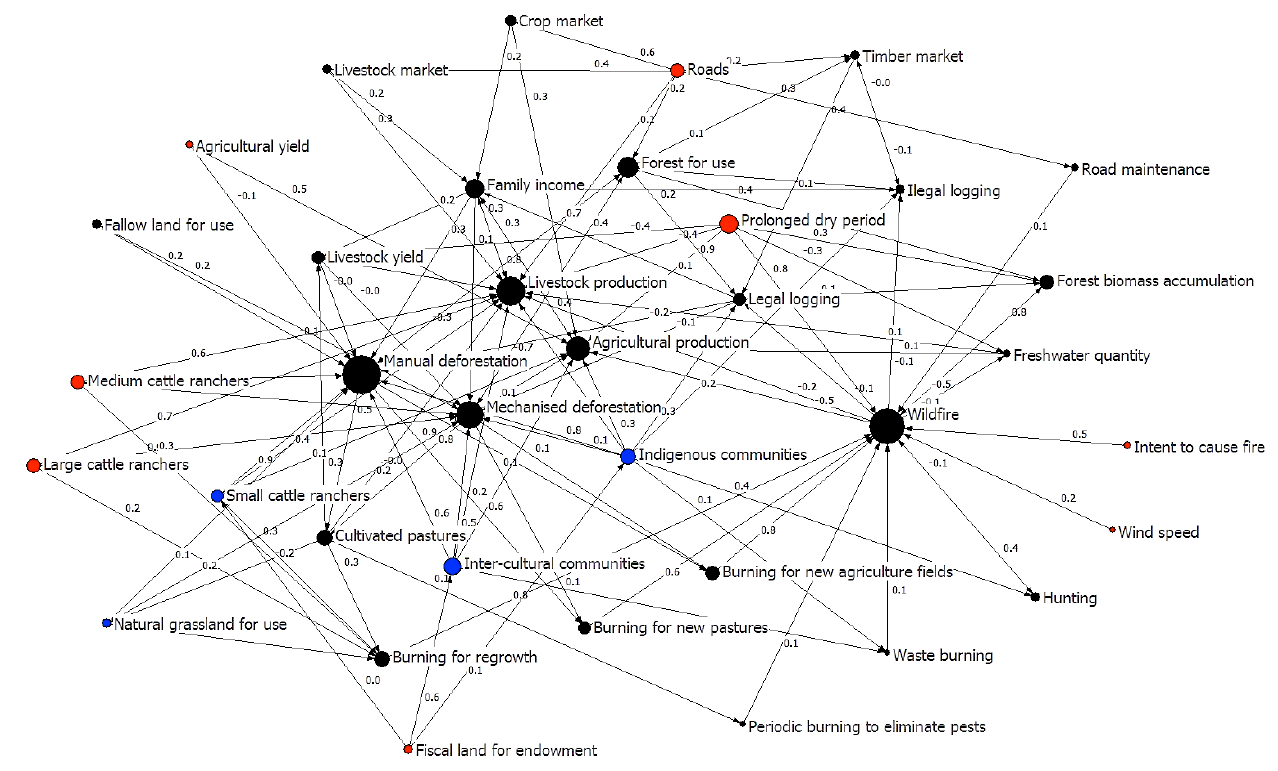
Fig. 3 . Network visualization of the augmented fuzzy cognitive map. Node size represents degree centrality where variables with higher degree have larger nodes. Transmitter variables are presented in red and ordinary transmitters in blue. Edge weights are normalized and numbers reduced to one decimal only for visualization (value 0.0 represents